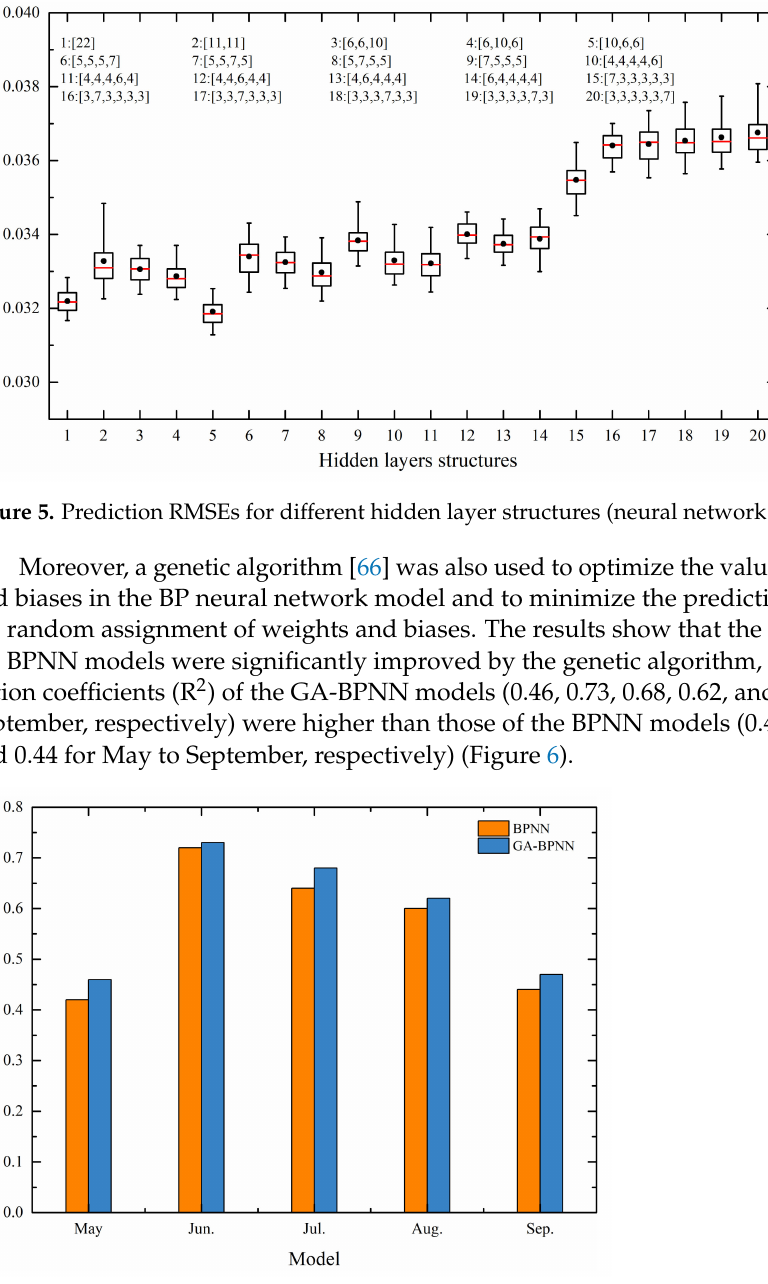
Figure 6. Comparison of the performances of the BPNN and GA-BPNN models for each